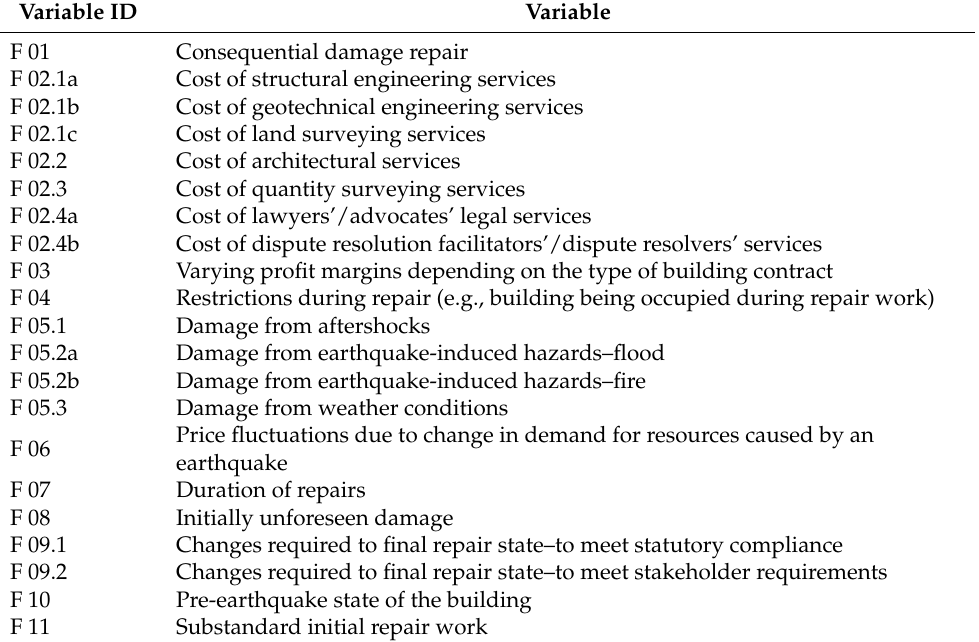
Table 2. Variables considered in the